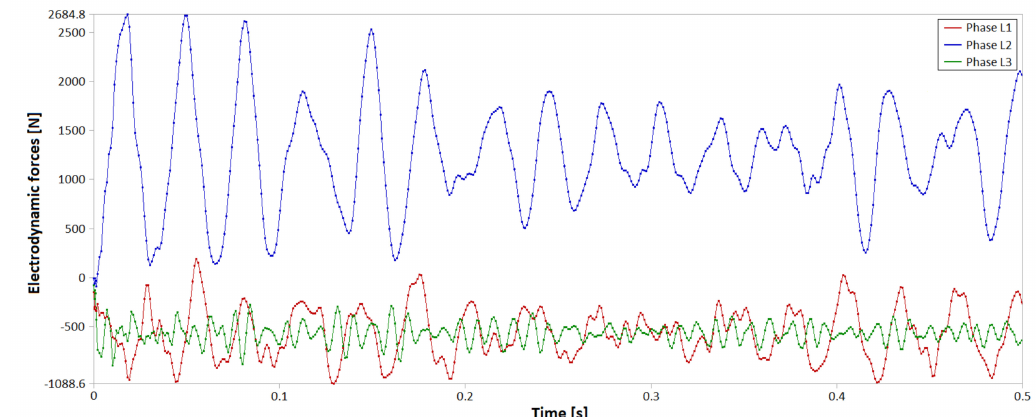
Figure 16. Results of tested quantities for low voltage switchgear: electrodynamic forces (points for L1, L2, L3 from the bottom).